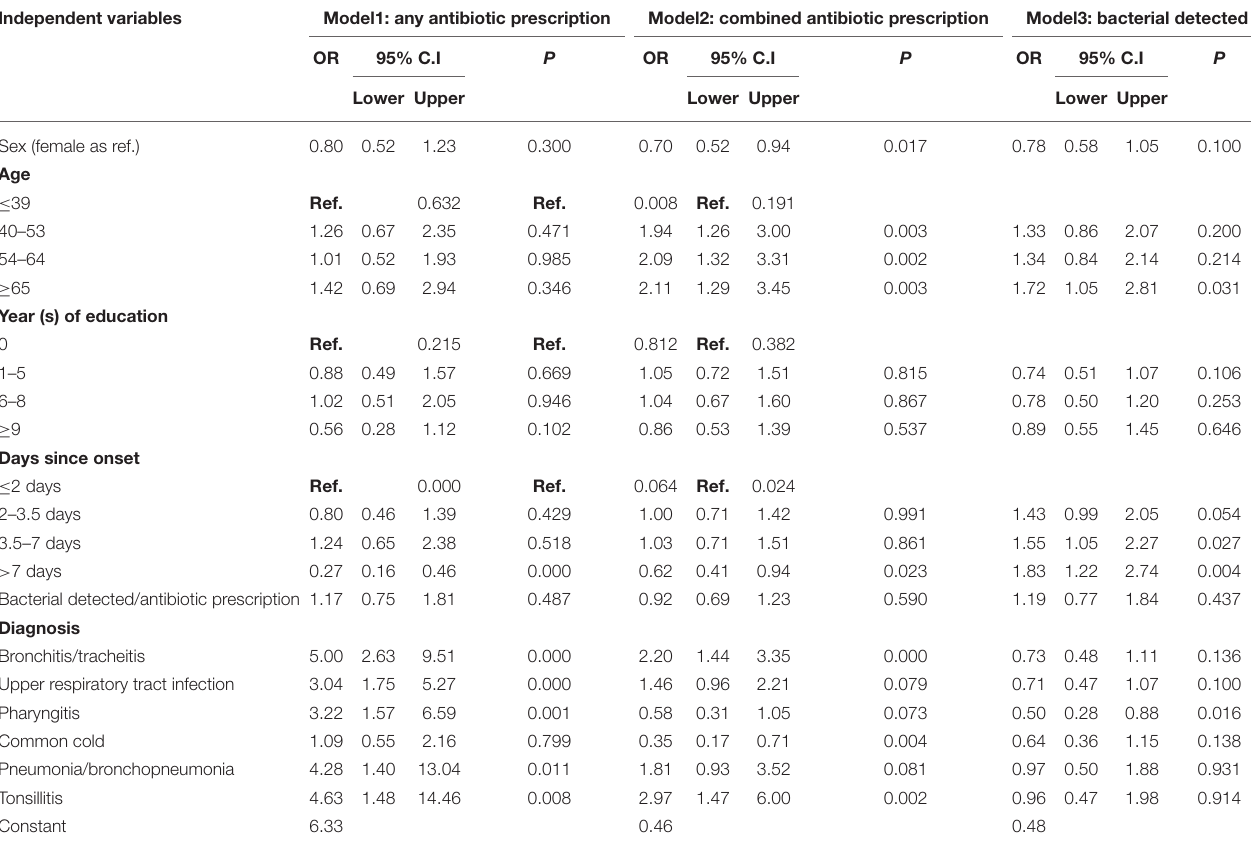
TABLE 2 | Multivariable logistic regression statistics between diagnosis and antibiotic prescription or bacterial isolation. Independent variables Model1: any antibiotic